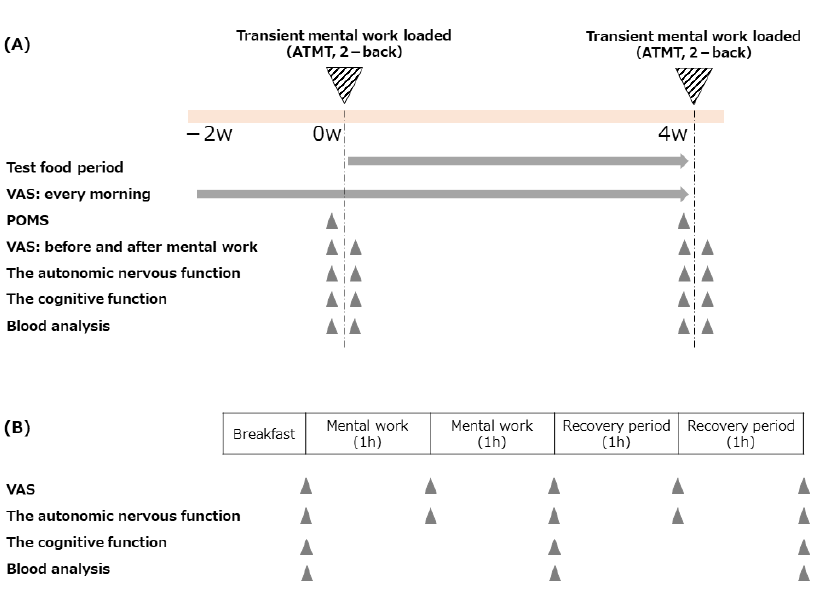
Figure 1. The outline of this study. ( A ) The overall outline of the test period. ( B ) The schedule details for days with transient mental work loaded.